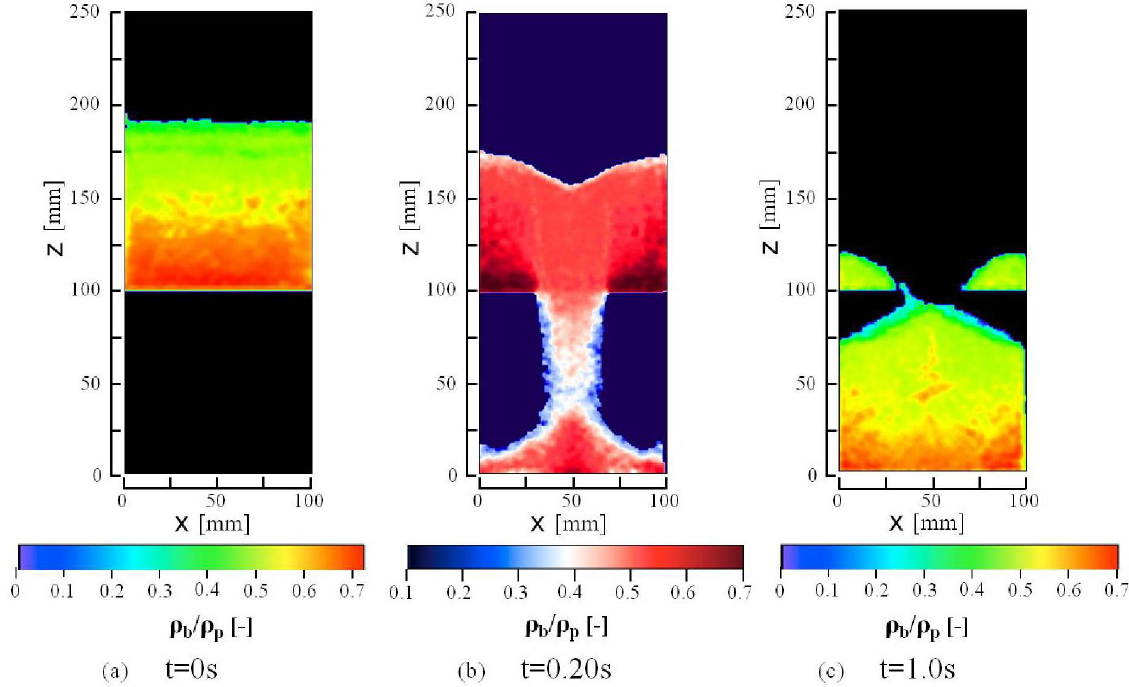
Figure 8. Calculated iso-contour of packing fraction ρ center cross-section of the computational domain y = 2.5 mm. The packing fraction is the calculated value averaged in the air computational cell.